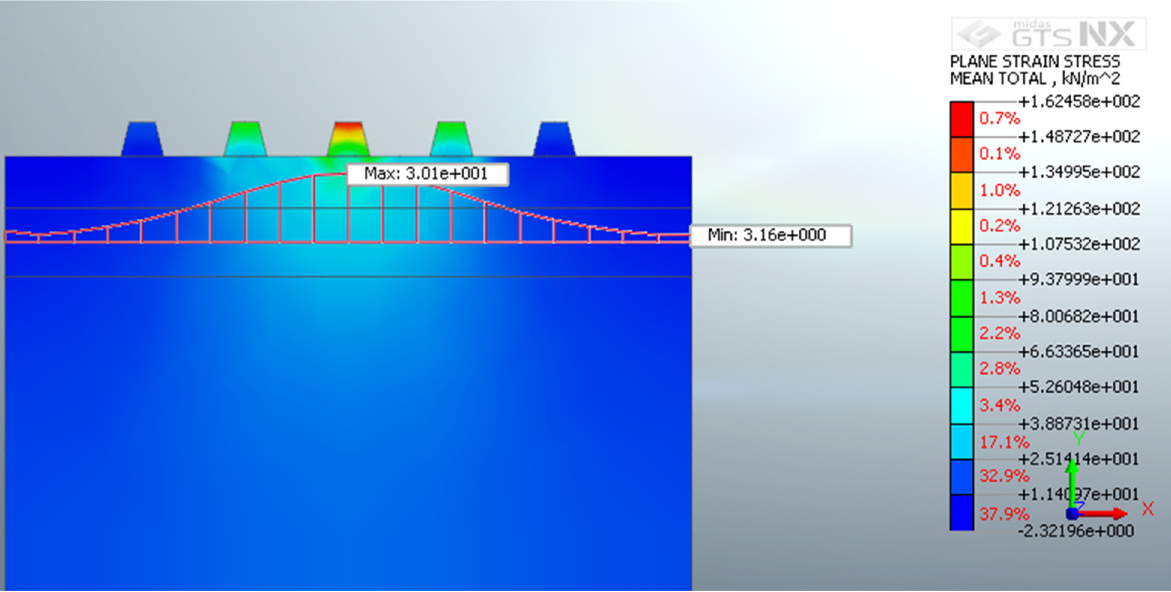
Figure 9: Vertical stress distribution [ kPa ] – maximum value of 30 kPa at the level of 95 cm below the running surface of the